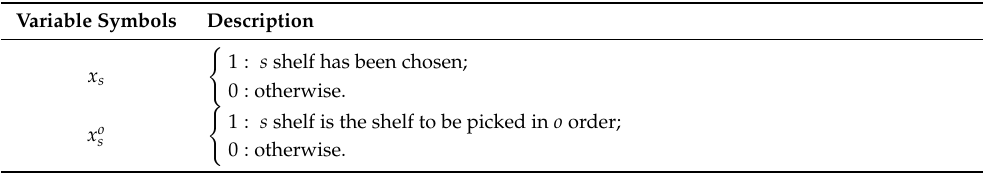
Table A2. Variable symbols description of model static picking order to determine the target shelf (see Section 2.4).